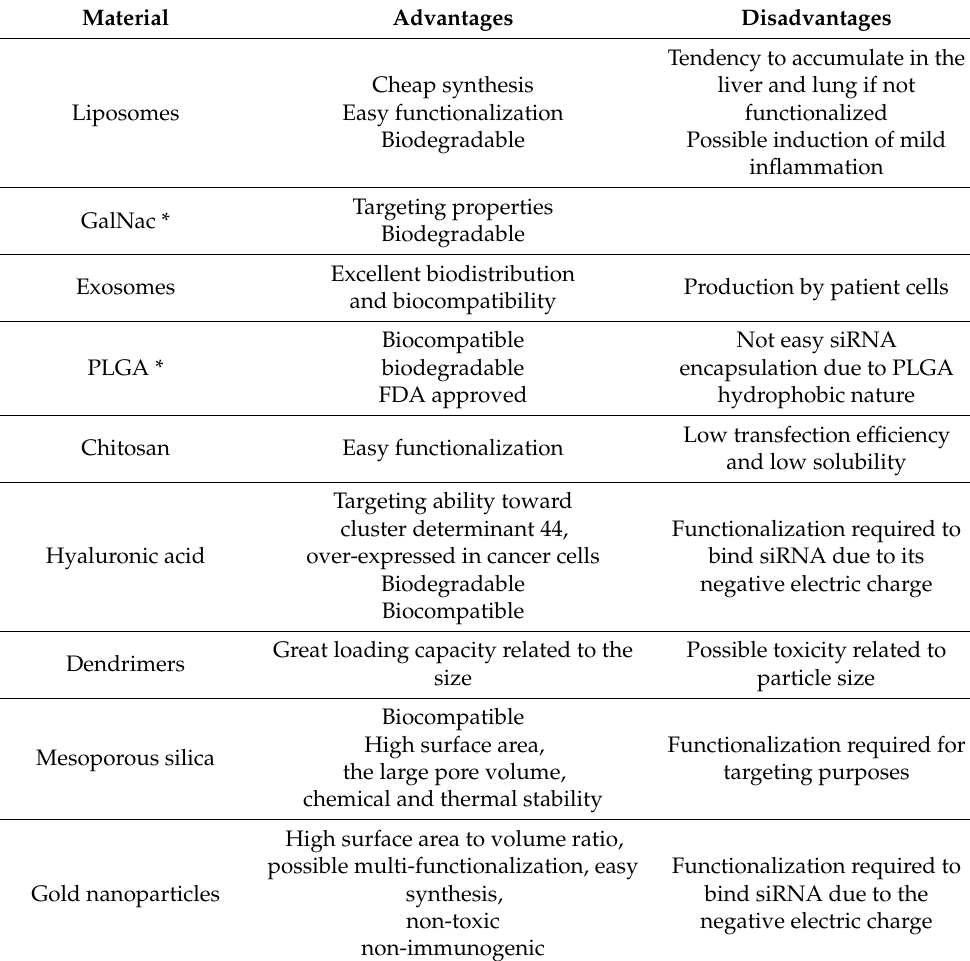
Table 1. siRNA delivery